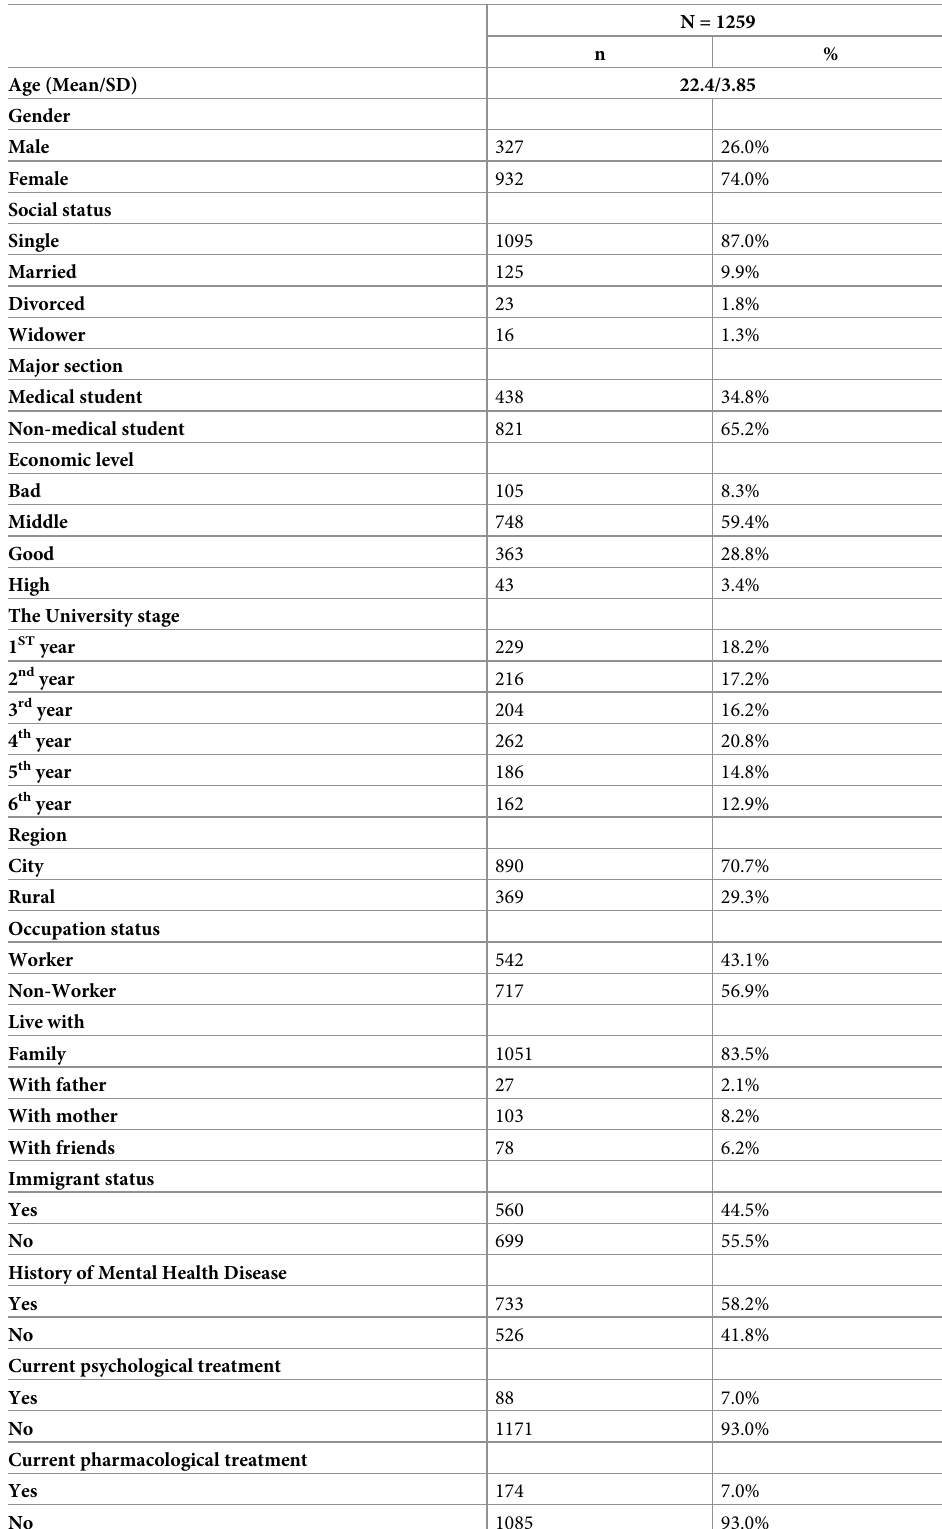
Table 1. Baseline characteristics of the